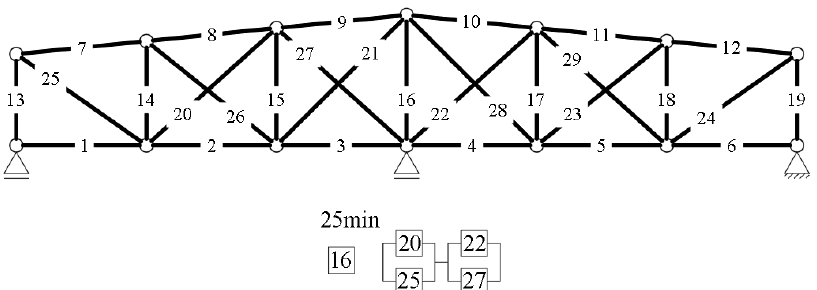
Figure 10. Statically indeterminate structure with six degrees of freedom with intermediate support (after 1st reduction) and corresponding cut-sets.